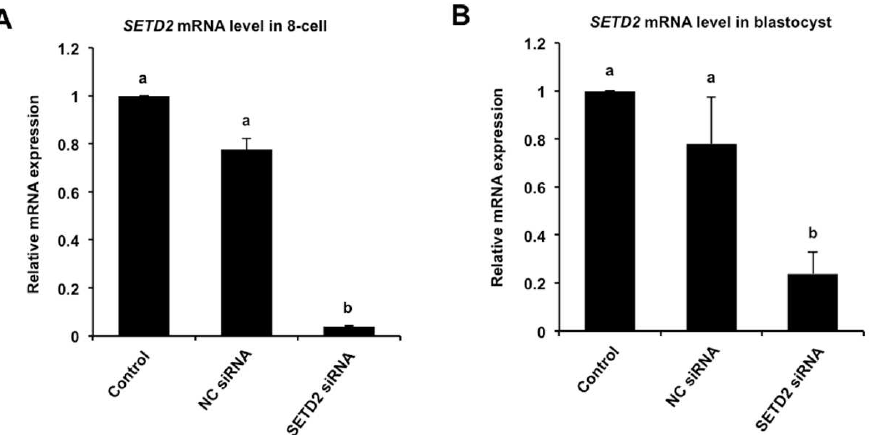
Figure 2. Effect of siRNA injection on the expression levels of SETD2 mRNA. Expression levels of SETD2 transcripts in eight-cell ( A ) and blastocyst ( B ) among different groups was analyzed by qPCR. The independent experiment was carried out for three times and 30 embryos in each group were at least included. NC, negative control. Data are expressed as mean ± S.E.M and different let- ters on the bars indicate significant differences ( p < 0.05).